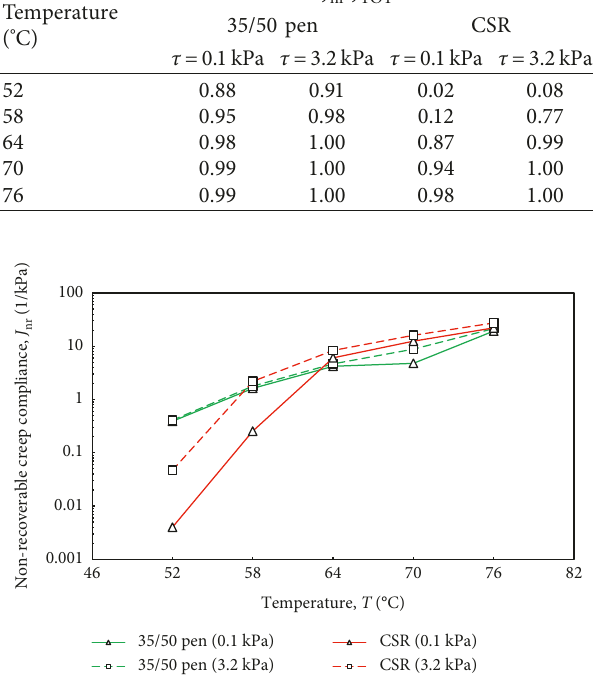
Figure 24: MSCR test results ( J nonrecoverable creep compliance.